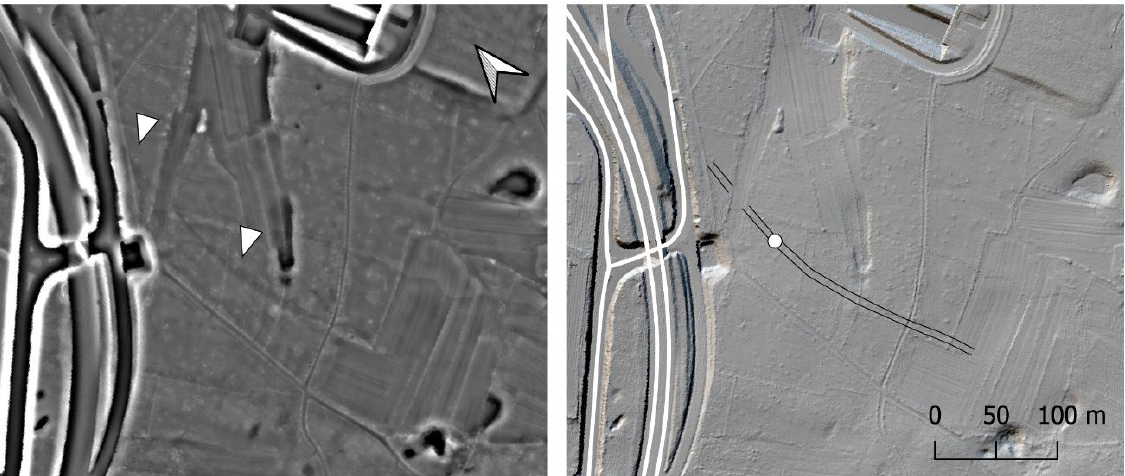
Figure 10. Zoomed view of area E of Figure 2 with the position of road tracks indicated by white arrows in the left picture (local relief model of an ALS-derived DTM) and by black lines in the right one (hill-shaded image of an ALS-derived DTM). Modern roads are indicated by white lines. The white circle: caliga hobnail.